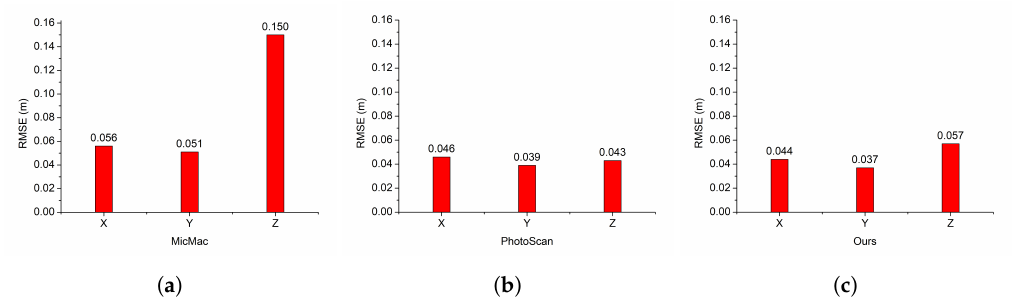
Figure 15. RMSEs for bundle adjustment tests of dataset 2 with GCPs: ( a ) MicMac; ( b ) PhotoScan; ( c ) Ours.